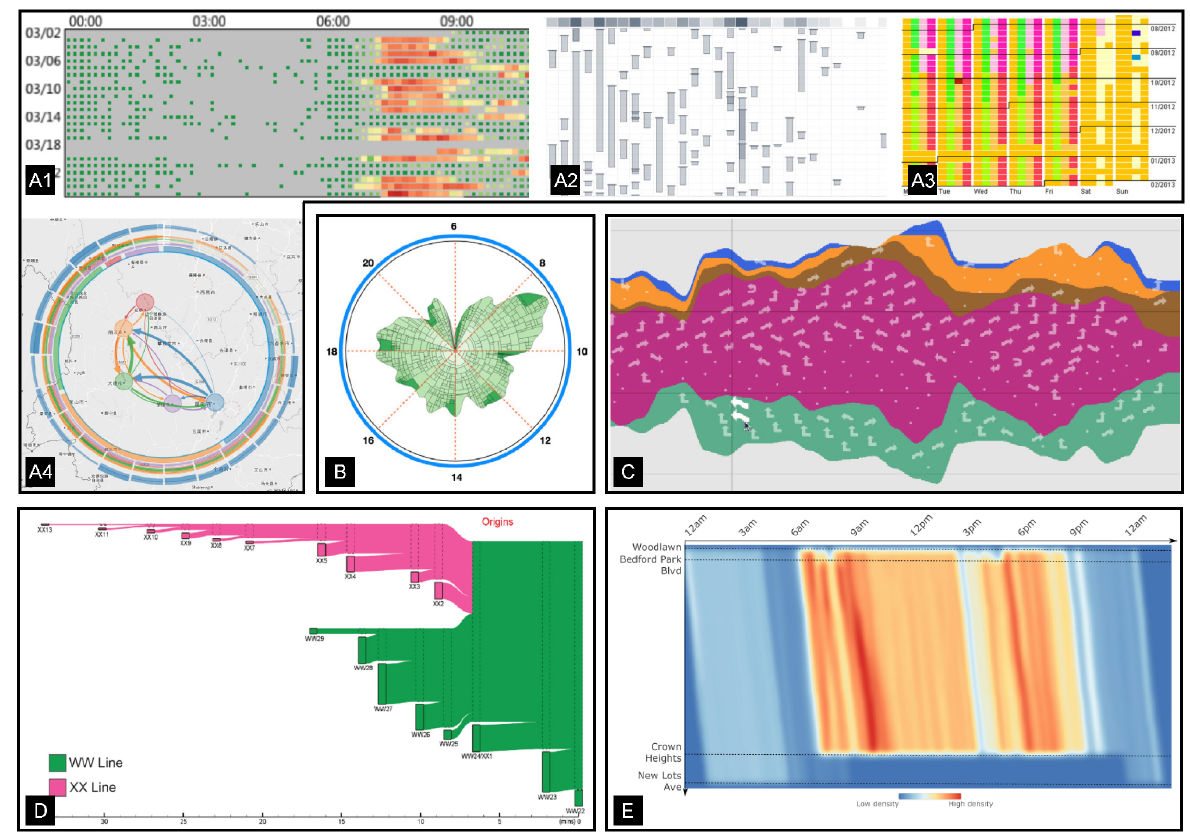
Fig. 4 Examples of (A) timeline visualization. (B) Circular area chart. (C) Streamgraph. (D) Sankey diagram. (E) Marey graph equipped with KDE. Reproduced with permission from Ref. [64] for (A1), c (cid:13) IEEE 2013; Ref. [65] for (A2), c (cid:13) IEEE 2022; Ref. [36] for (A3), c (cid:13) IEEE 2017; Ref. [14] for (A4), c (cid:13) IEEE 2016; Ref. [42] for (B), c (cid:13) IEEE 2016; Ref. [54] for (C), c (cid:13) IEEE 2011; Ref. [35] for (D), c (cid:13) The Authors 2015; Ref. [67] for (E), c (cid:13) IEEE